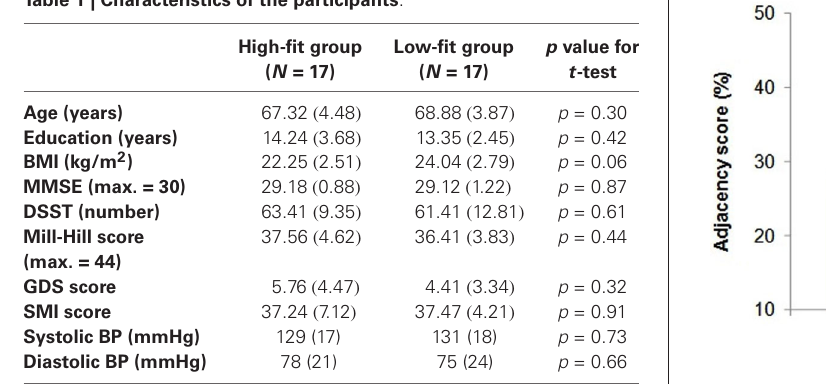
Table 1 | Characteristics of the participants .